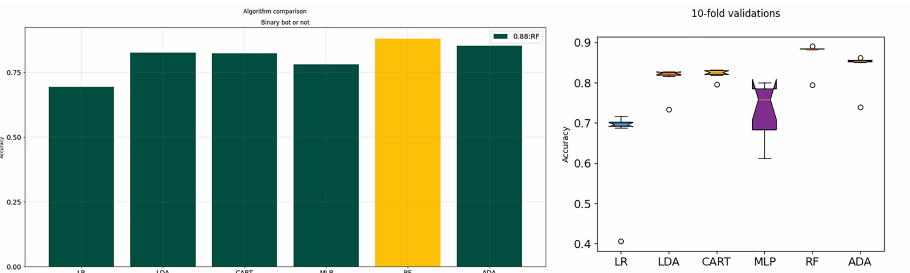
Figure 4. Random Forest performs better than the other classifiers. The figure on the right shows, that apart from highly accurate predictions, Random Forest is among the most stable, with relatively small fluctuations in the 10-fold validation